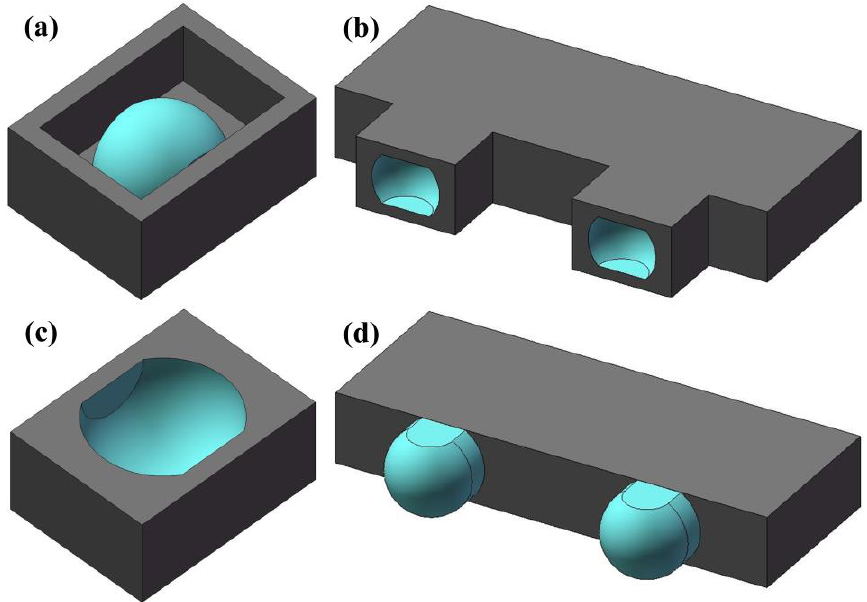
Figure 8. Models of ( a , c ) 3D microstructures and ( b , d ) queued 3D microelectrodes.